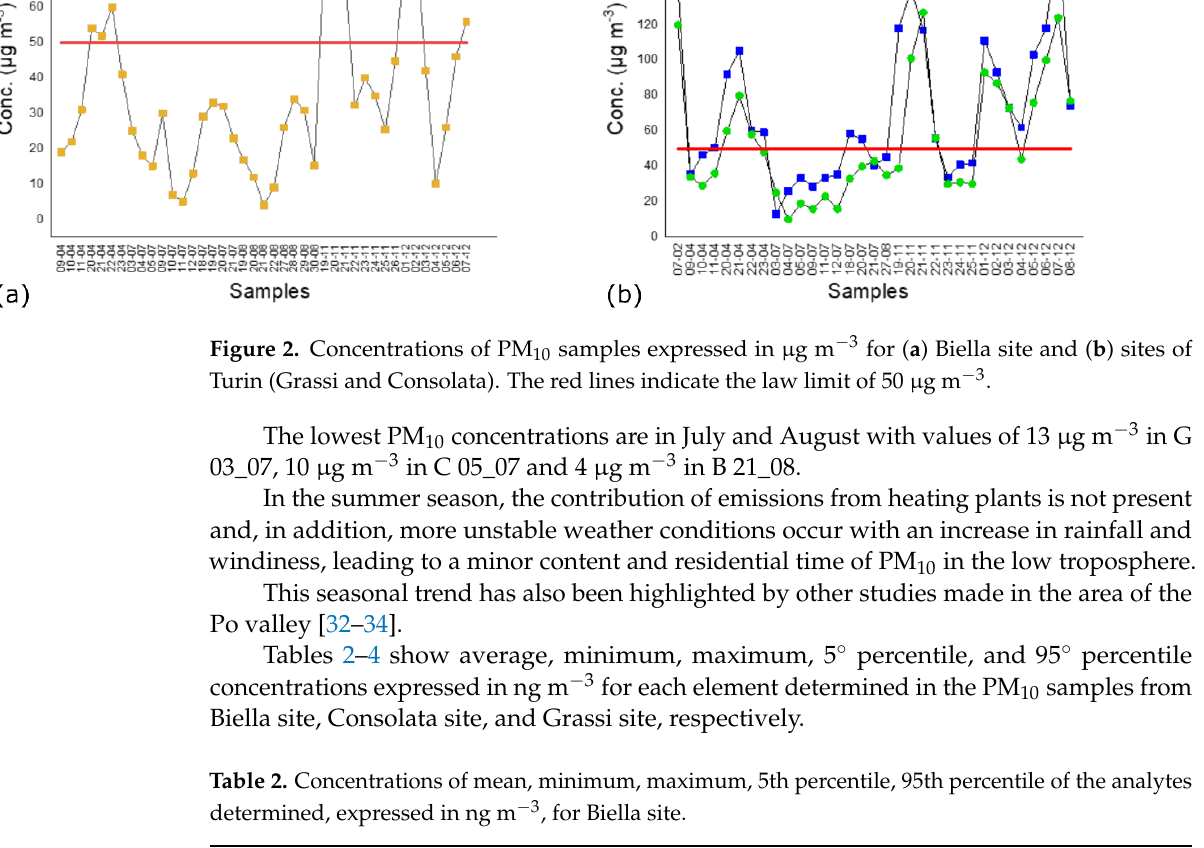
Table 2. Concentrations of mean, minimum, maximum, 5th percentile, 95th percentile of the analytes determined, expressed in ng m − 3 , for Biella